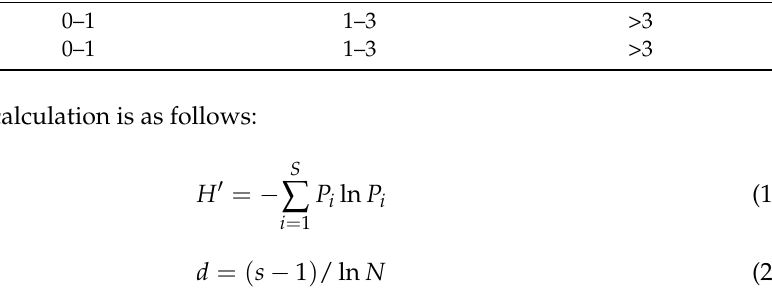
Table 1. Criteria for the ecological evaluation of water quality. Heavy Pollution Medium